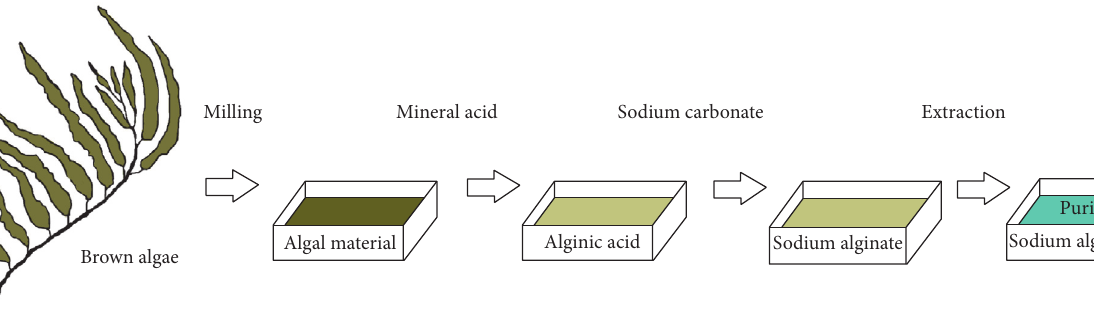
Figure 2: The procedure of sodium alginate extraction from brown algae